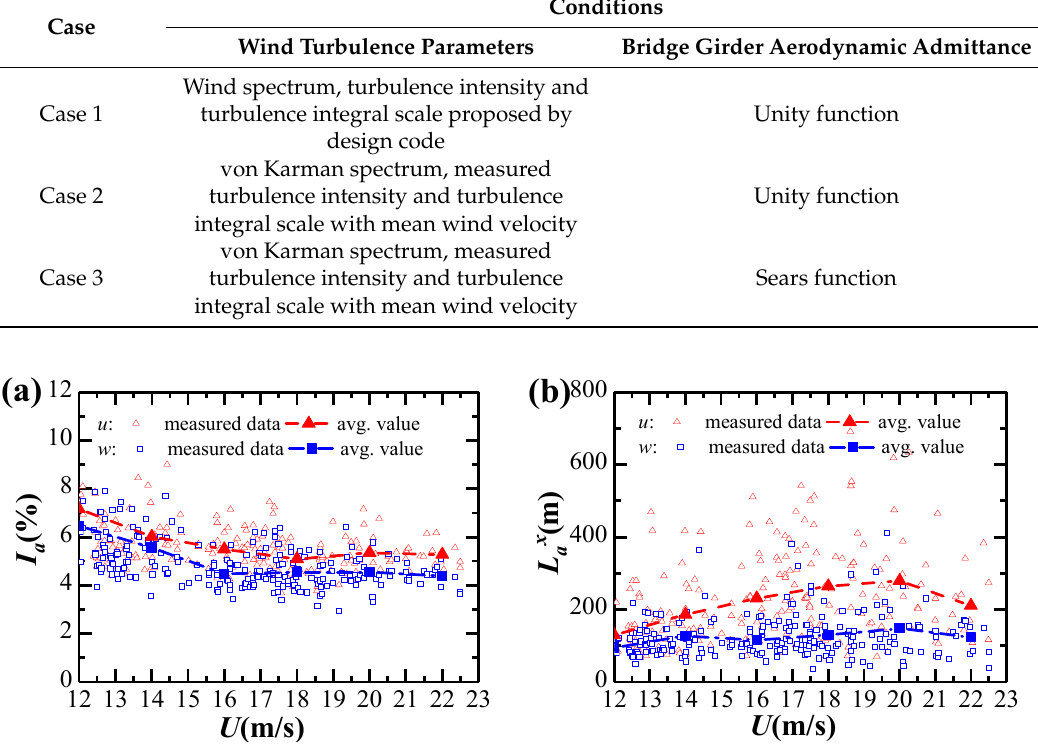
Figure 12. Dependence of turbulence intensity and turbulence integral scale on mean wind velocity: ( a ) Turbulence intensity ; ( b ) Turbulence integral scale.